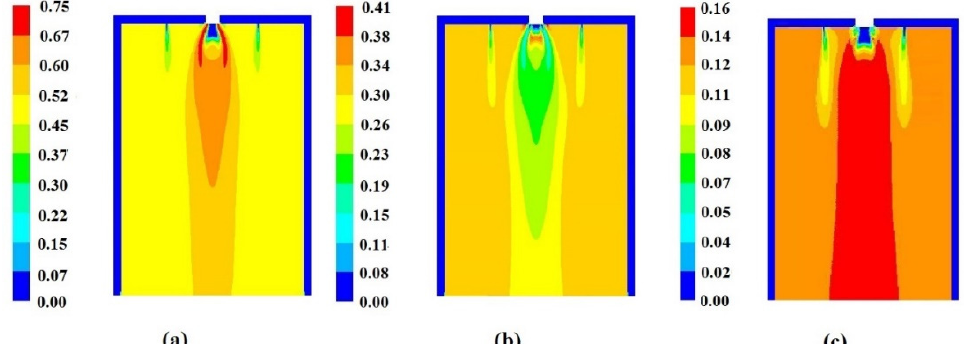
Figure 15. Species distribution in the plane passing through the centers of two powder feeding ports of design No. 6: ( a ) H 2 , ( b ) H 2 O, and ( c ) CO. ( b ) H 2 O, and ( c )